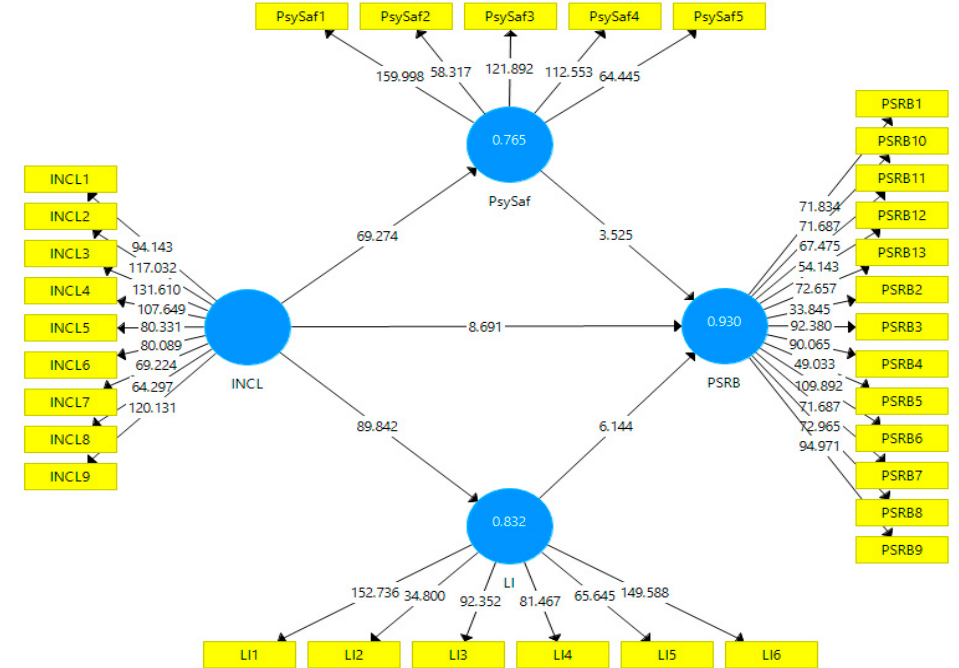
Figure 3. Structural